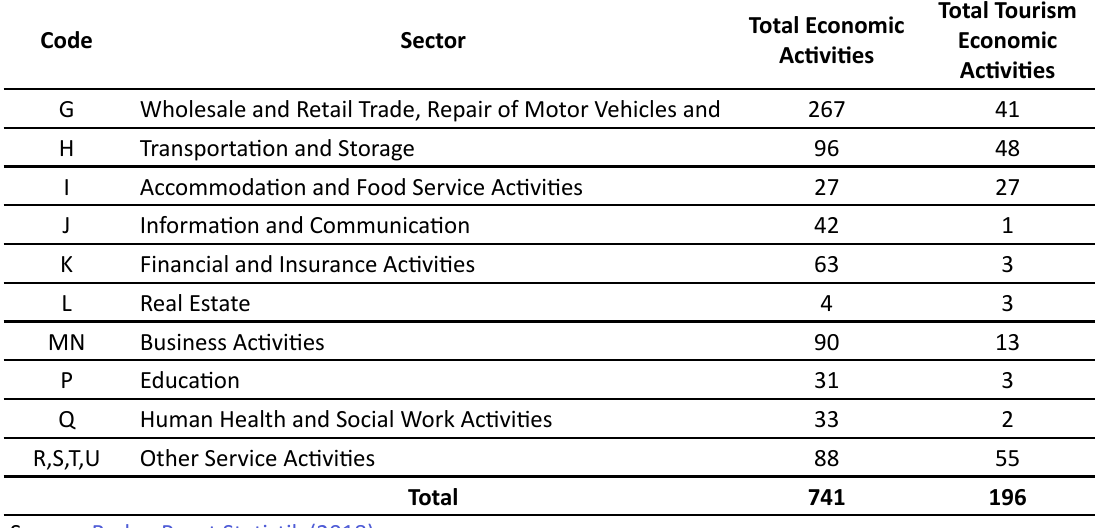
Table 3: The Total Coverage of Tourism Economic Activities Based on the KBLI 2015 and International Recommendations for Tourism Statistic (IRTS) Code Sector